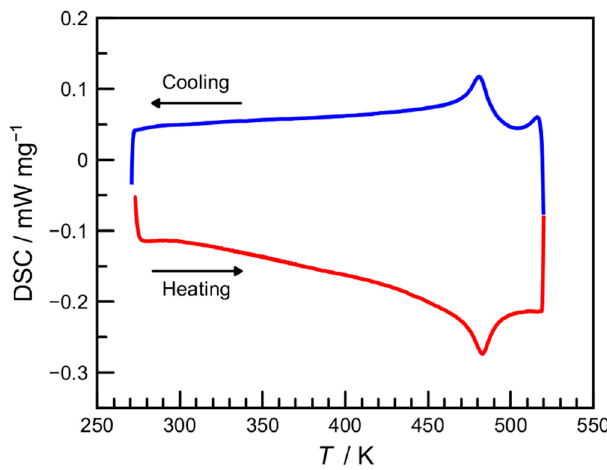
Figure 4. Differential scanning calorimetry (DSC) curves of 1 recorded over the temperature range of 273–518 K in the heating (red) and cooling (blue) modes at a sweep rate of 5 K min –1 .